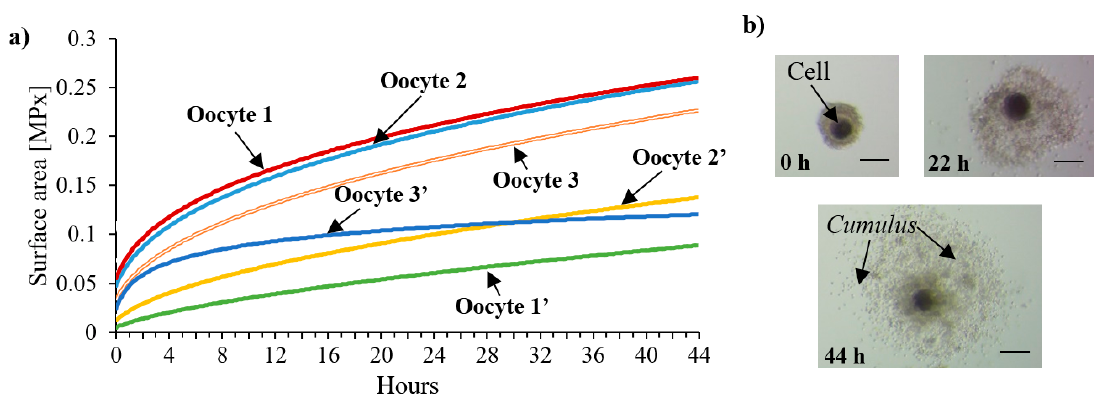
Figure 8. Development of porcine oocytes during the in vitro maturation (IVM) process performed on the LOC platform: ( a ) graph representing the expansion of oocytes’ size in two independent experiments, ( b ) microscope image indicating growth of cumulus cells. Scale bar—120 µm.